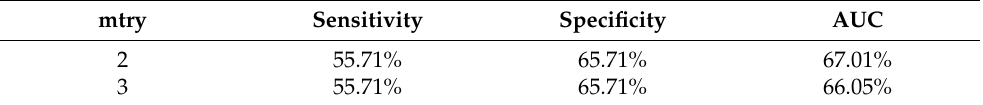
Table 7. Performance parameters for the model with three